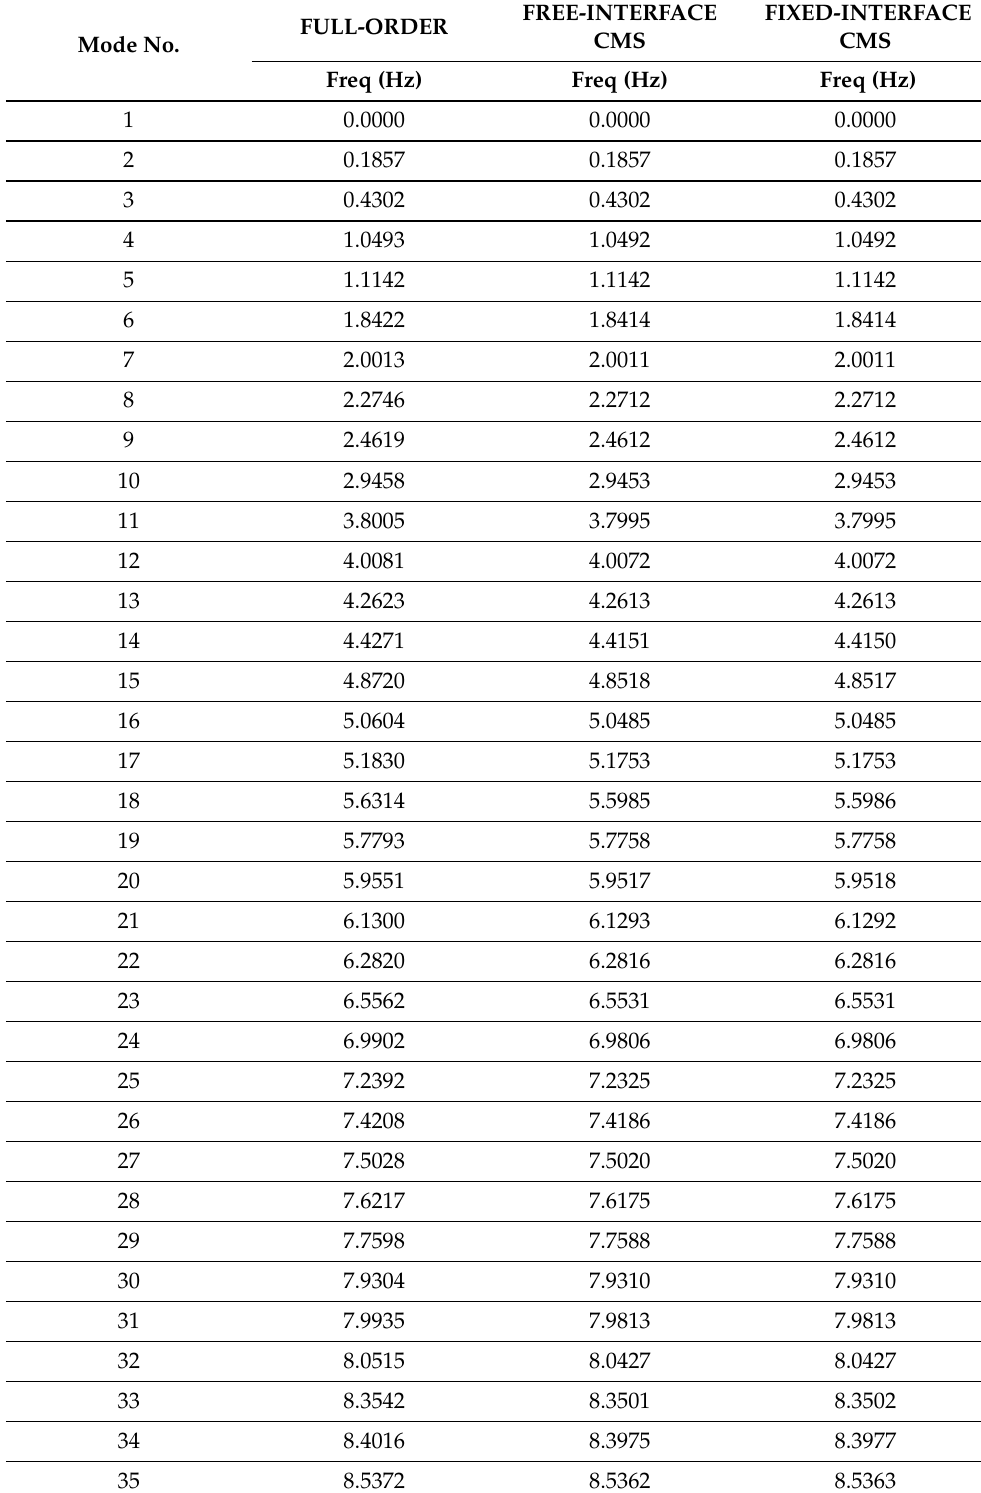
Table 1. Full-Order and Reduced-Order